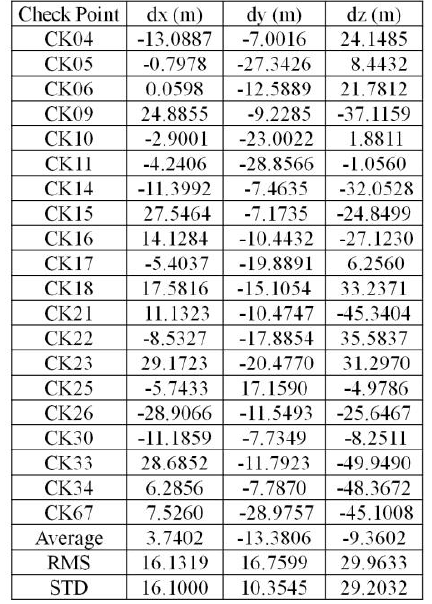
Table 4 The result of boresight